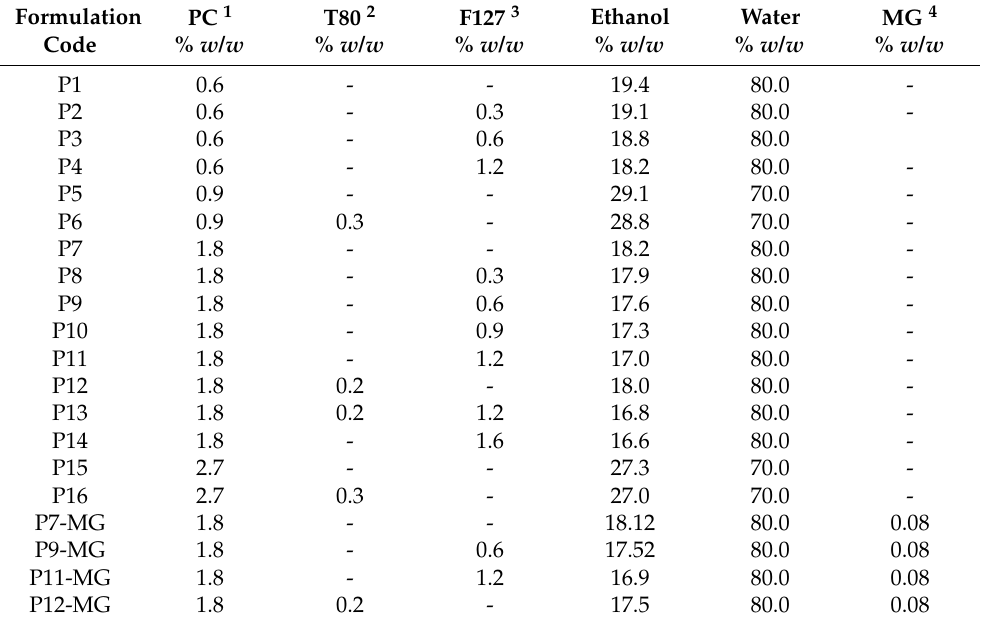
Table 1. Composition of the ethosomes and plurethosomes.